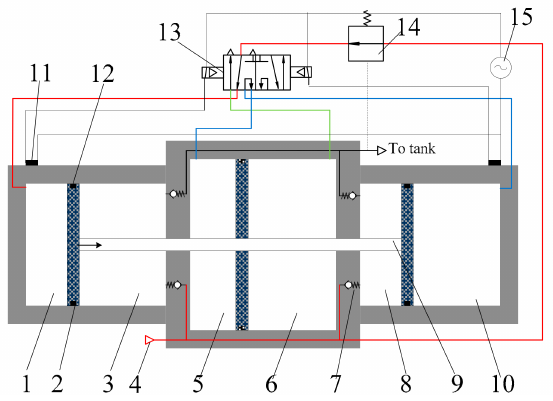
Figure 2. Structure schematic diagram of booster regulator with energy recovery (VBA-R). 1: